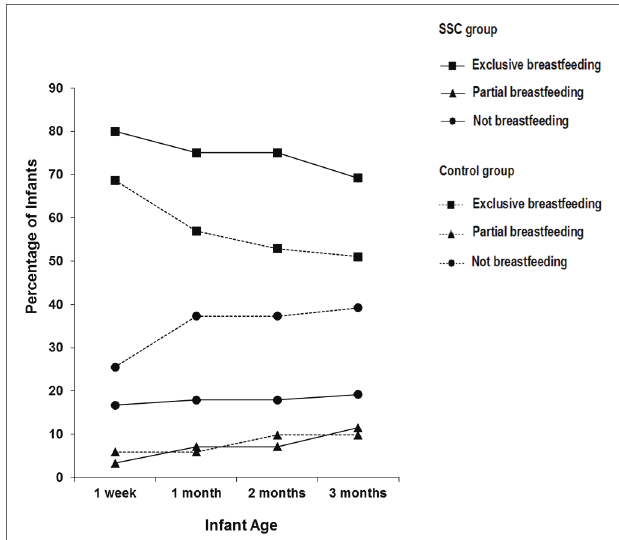
FIGURE 1 | Percentage of infants reported to be exclusively breastfeeding, partially breastfeeding, and not breastfeeding in the SSC and control groups on each of the visits. Reprinted from Bigelow et al. (2014, p. 57). Copyright © 2013 Michigan Association for Infant Mental Health (MAIMH), published by Wiley Periodicals, Inc. Used with